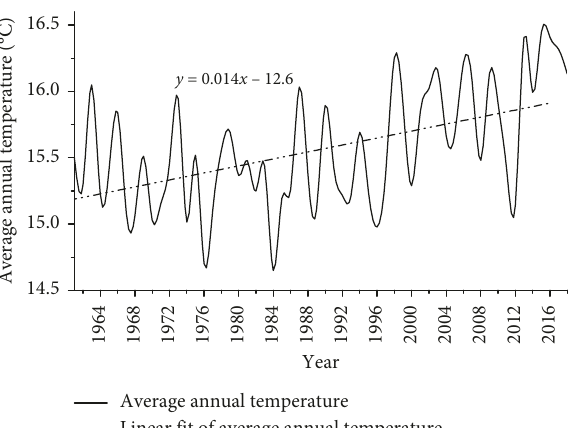
y = –1.502 x + 4170.8